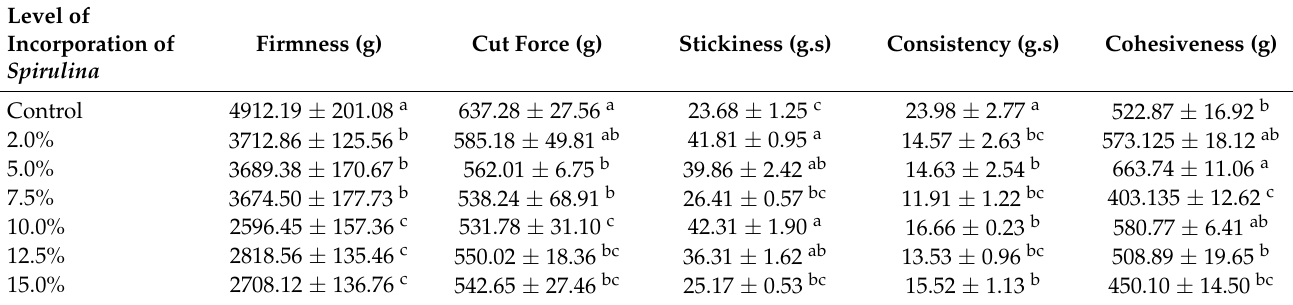
Table 6. Textural attributes of different formulations of Spirulina biomass enriched